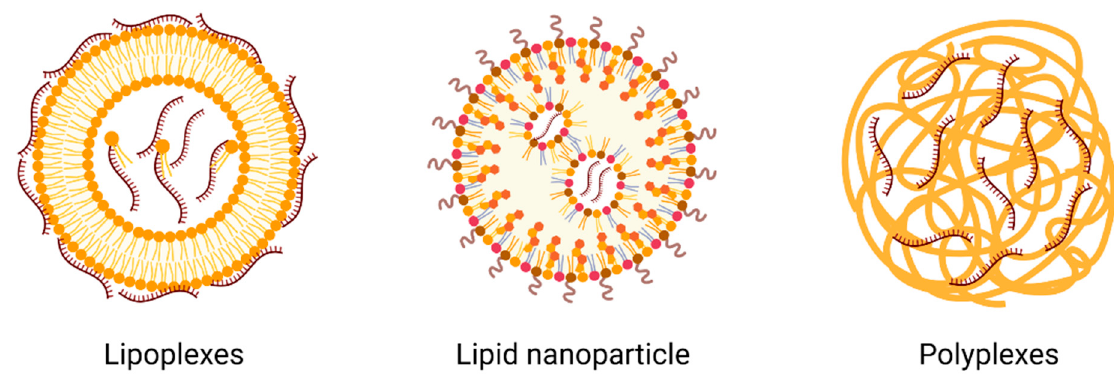
Figure 5. Structures of lipoplexes, lipid nanoparticles, and polyplexes.